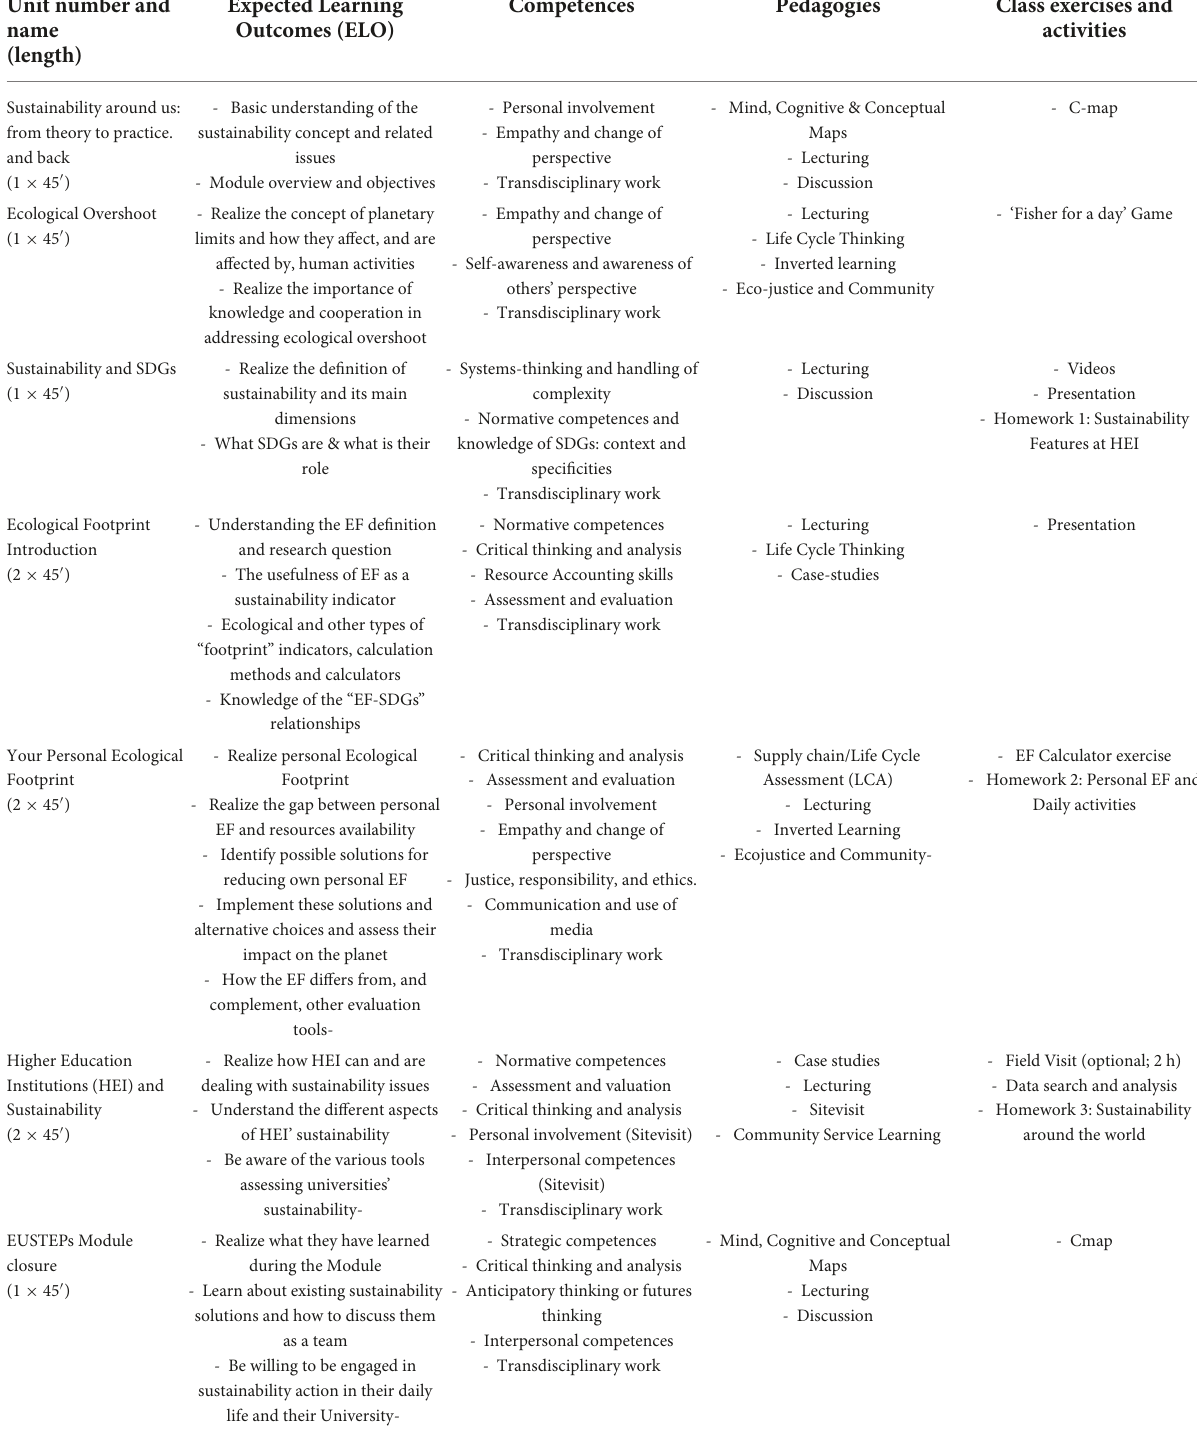
TABLE 4 Revised EU STEPs Module’s